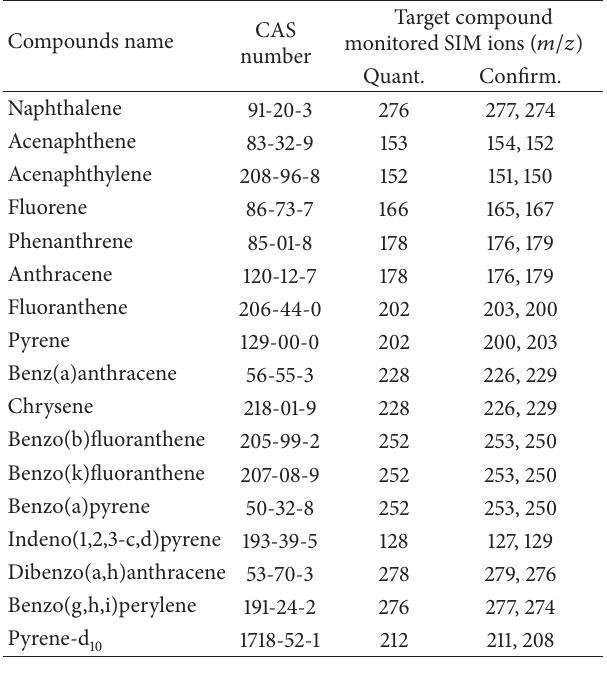
Table 1: Representing the PAHs used and respective analytical ions used for quantification.